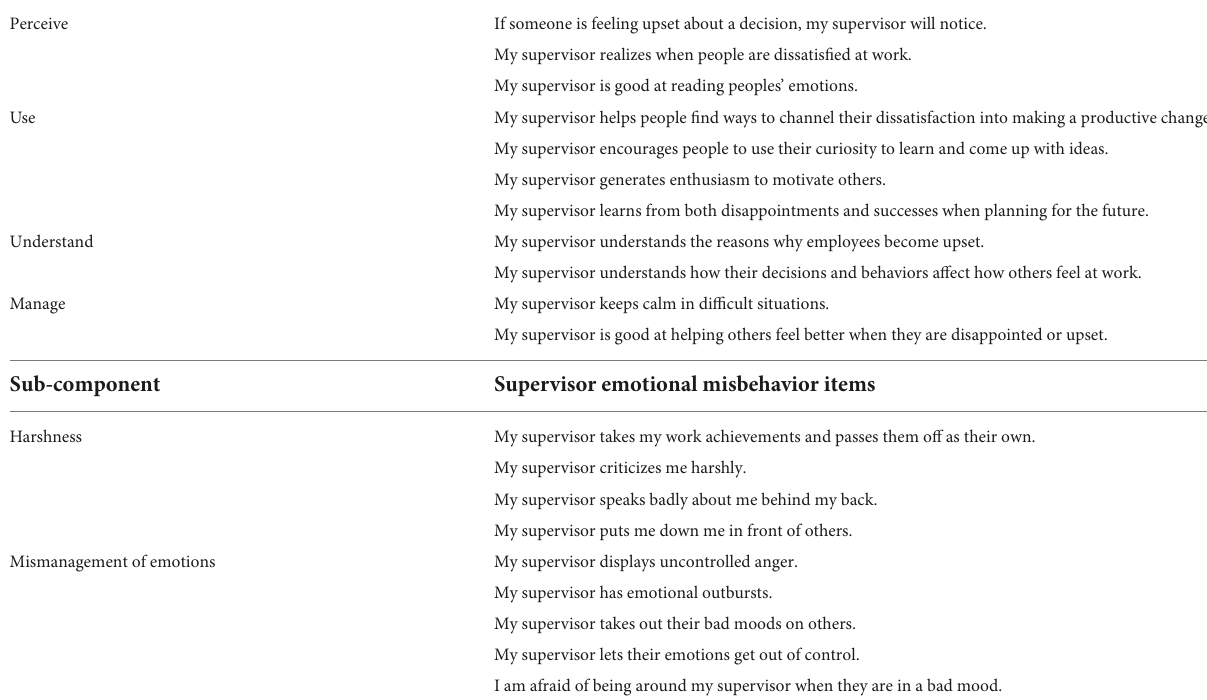
Sub-component Supervisor emotionally intelligent behavior items